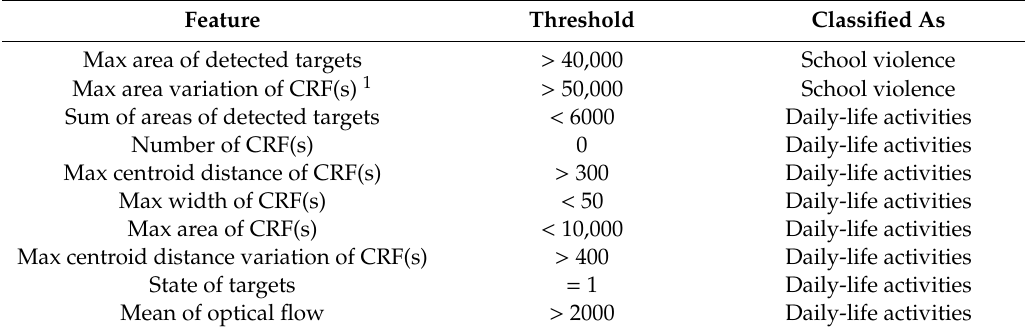
Table 5. Selected features for DT (Decision Tree) and their corresponding thresholds (unit: pixel 2 for area, and pixel for the